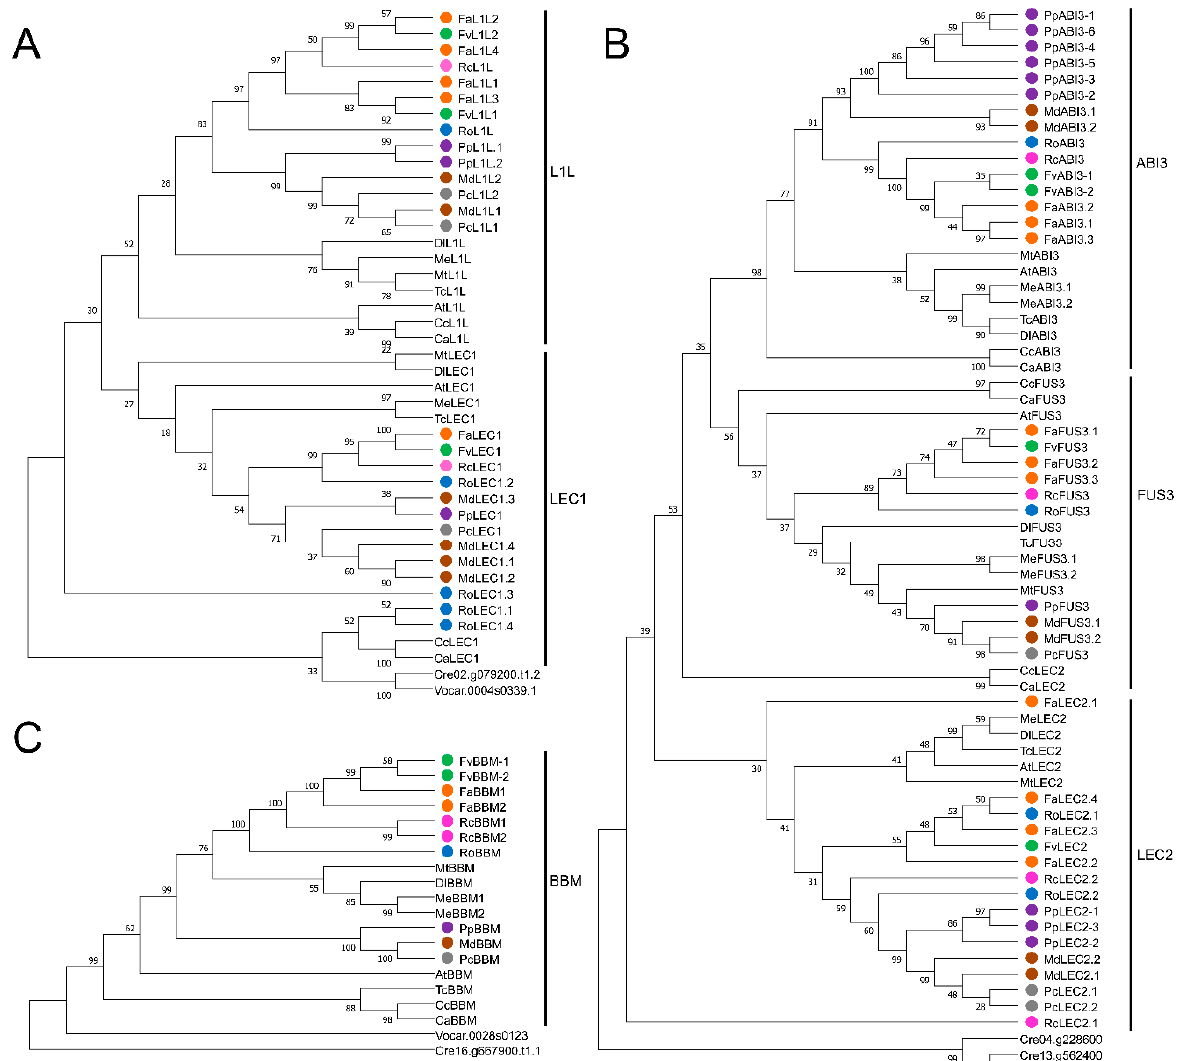
Figure 6. Proteins phylogenetic relationships of LAFL-B within the Rosaceae family. ( A ) Phylogenetic tree for LEC1 and, L1L. ( B ) Phylogenetic tree for LEC2, FUS3, and ABI3. ( C ) Phylogenetic tree for Babyboom (BMM) proteins. Numbers in nodes of the phylogenetic trees indicate bootstrap values (1000 replicates). Orthologous sequences of green algae Volvox carteri and Chlamydomonas reindhartii were used as outgroup. Color circles indicate proteins of different Rosaceae species. LEC1: Leafy cotyledon1; L1L: Leafy cotyledon1-like; LEC2: Leafy cotyledon2; FUS3: Fusca3; ABI3: Abscisic acid insensitive3; BBM: Babyboom; Fa: Fragaria × ananassa ; Fv: Fragaria vesca ; Ro: Rubus occidentalis ; Rc: Rosa chinensis ; Md: Malus × domestica ; Pp: Prunus persica ; Pc: Pyrus communis; At: Arabidopsis thaliana; Ca: Coffea arabica; Cc: Coffea canephora; Dl: Dimocarpus longan; Me: Manihot esculenta; Mt: Medicago truncatula; Tc : Theobroma cacao . A list of accession numbers for protein sequences is available in Table S3.